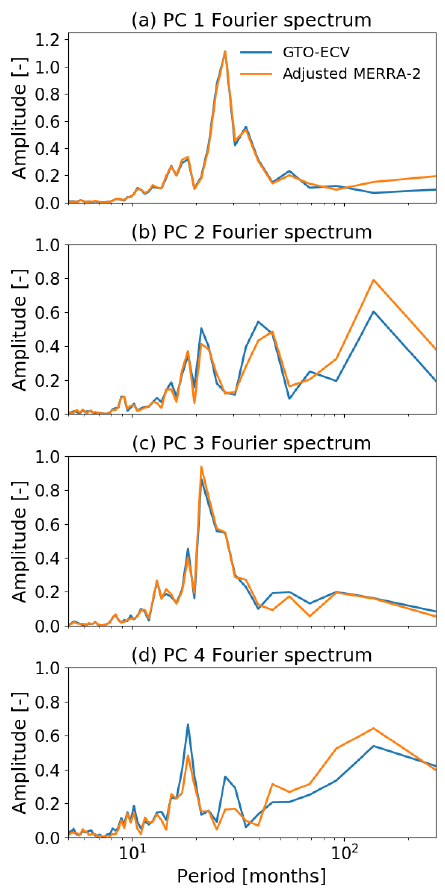
Figure 14. Principal component (PC) time series for the first four EOFs (from top to bottom) for GTO-ECV (blue) and adjusted MERRA-2 (orange). The green curves denote appropriate climatic indices: (a) QBO at 30hPa, (b) solar flux at 10.7cm, and (d) the Multivariate ENSO Index (MEI). All indices were detrended, and a Savitzky–Golay smoothing filter with a window length of 13 months was applied. The solar flux is given in solar flux units (SFU), defined as 1SFU = 10 − 22 Wm − 2 Hz − 1 . The numbers provided in the bottom part of the plots indicate the correlation coefficients be- tween GTO-ECV and adjusted MERRA-2 PCs ( ρ 1 , black), between the GTO-ECV PC and the selected proxy ( ρ 2 , blue), and the ad- justed MERRA-2 PC and the selected proxy ( ρ 3 , orange), respec- tively. For PC3 (c) no proxy is shown (see text for more details).